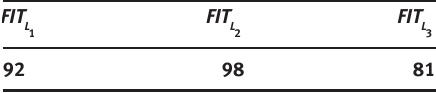
Table 3. FIT Indicators for Scenario 1